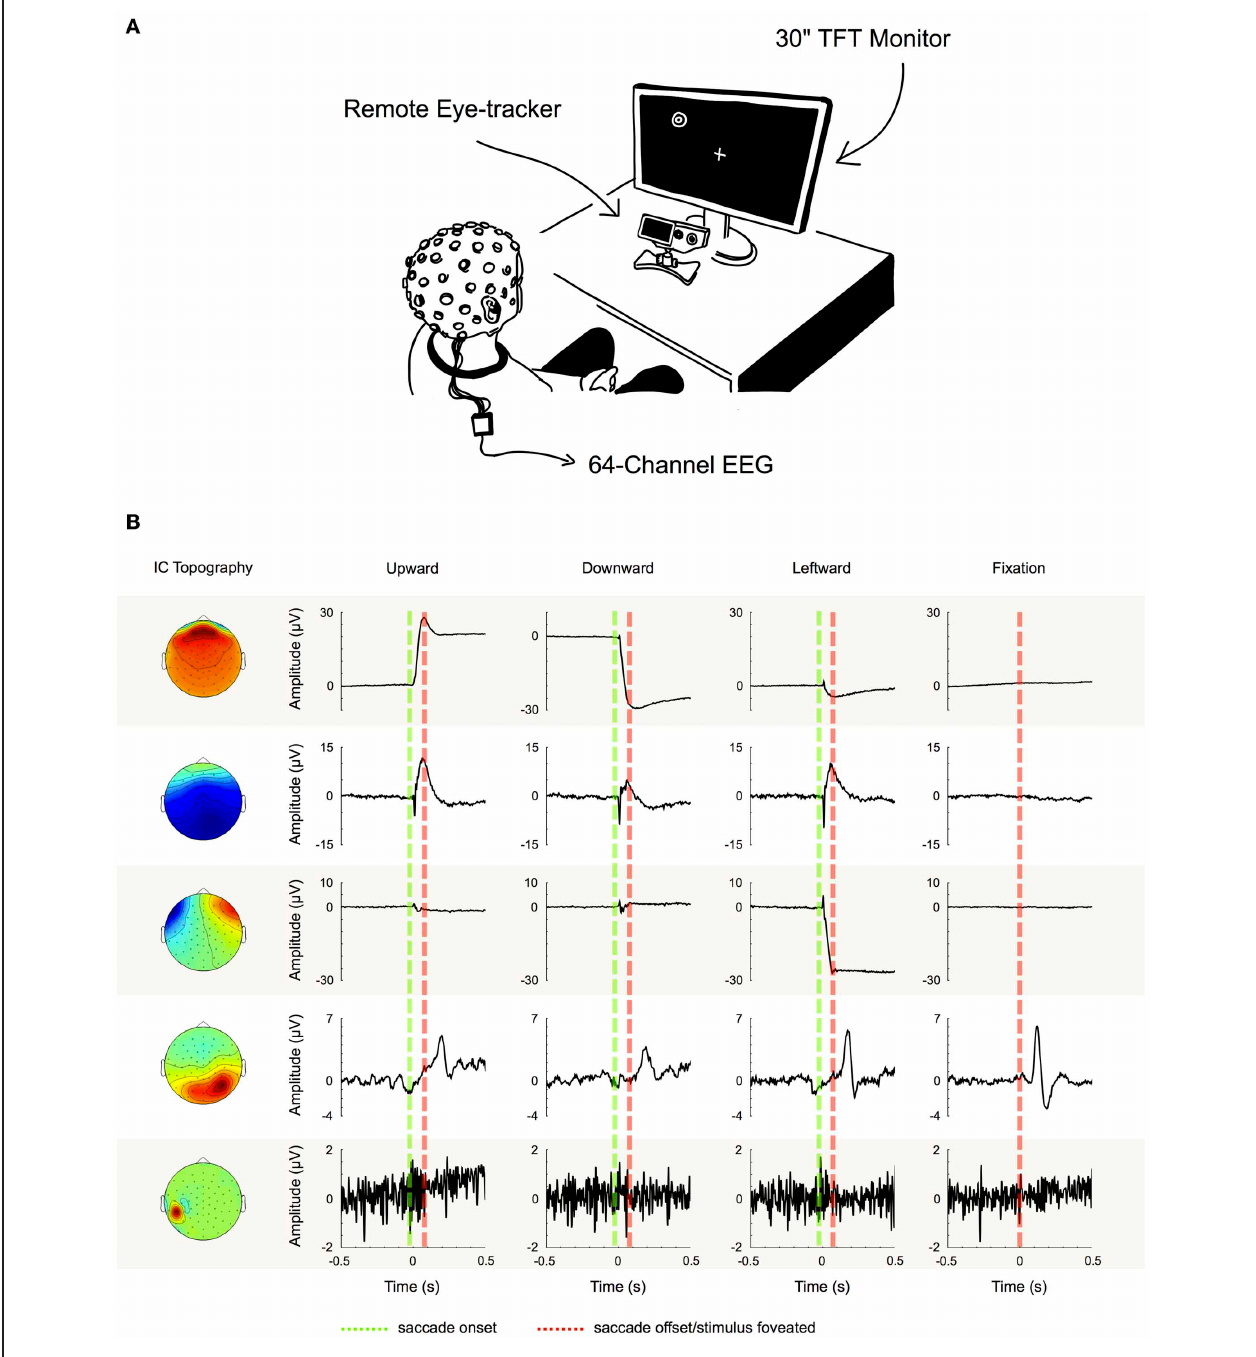
FIGURE 2 | Component examples and correction procedure. (A) Experimental setup. (B) Examples of five typical IC topographies and their activations, as we found them similarly for all of our subjects. The first three ICs can be classified as eye movement-related as their activations display high variance during saccade intervals (between green and red dotted line), while being inactive during fixation periods (left and right of green and red dotted line). IC 4 on the other hand displays its largest variance during fixation. Therefore, it cannot be attributed to artifacts produced during saccade execution, but instead to